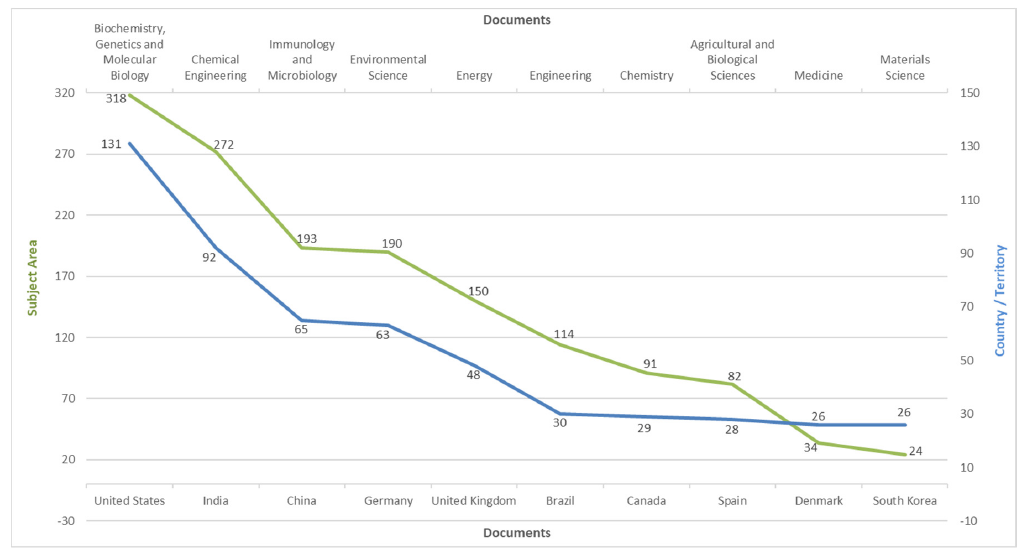
Figure 2. Documents by area of knowledge and country (2010–2019). Source: elaborated by the authors based on Scopus [55].